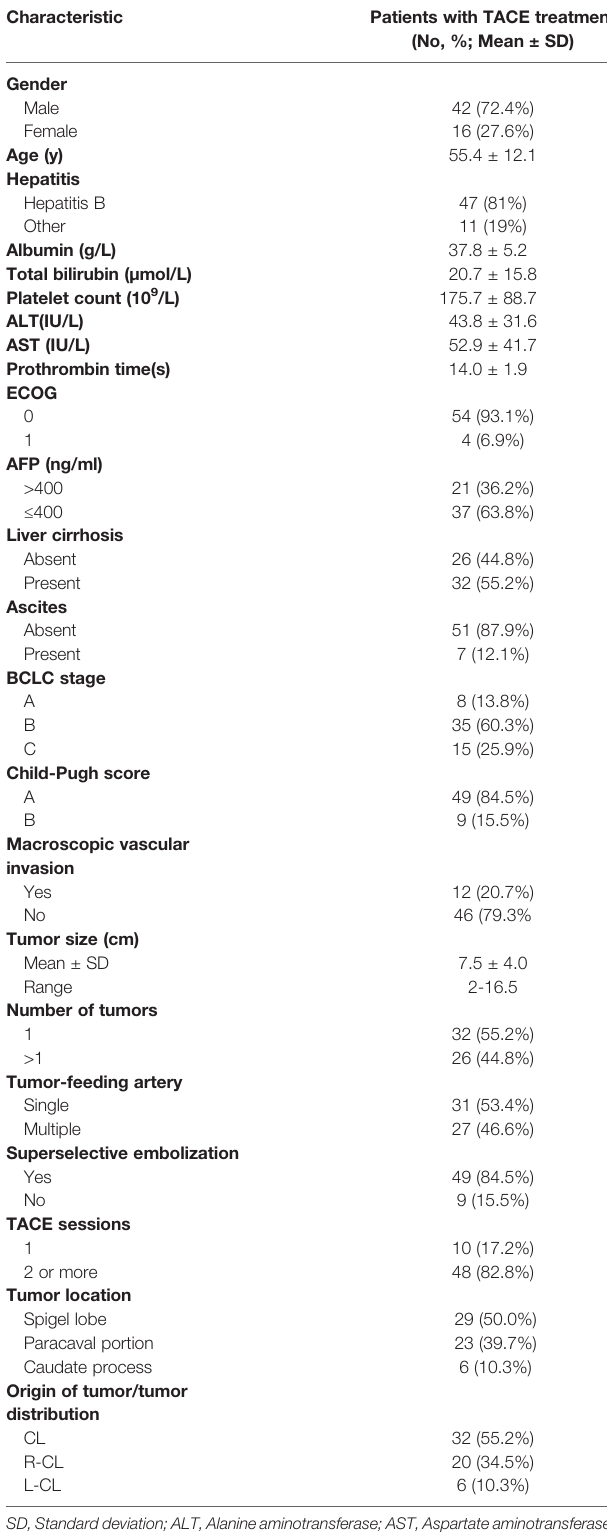
TABLE 1 | Baseline clinical characteristics of